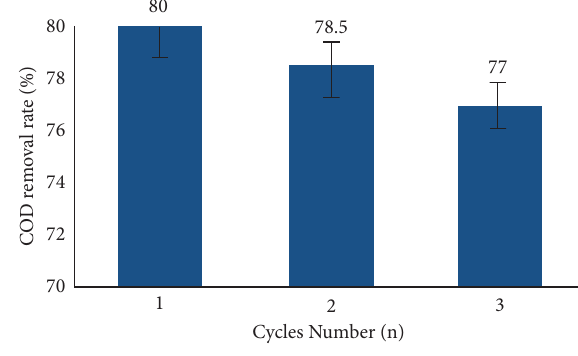
Figure 6: COD removal rate